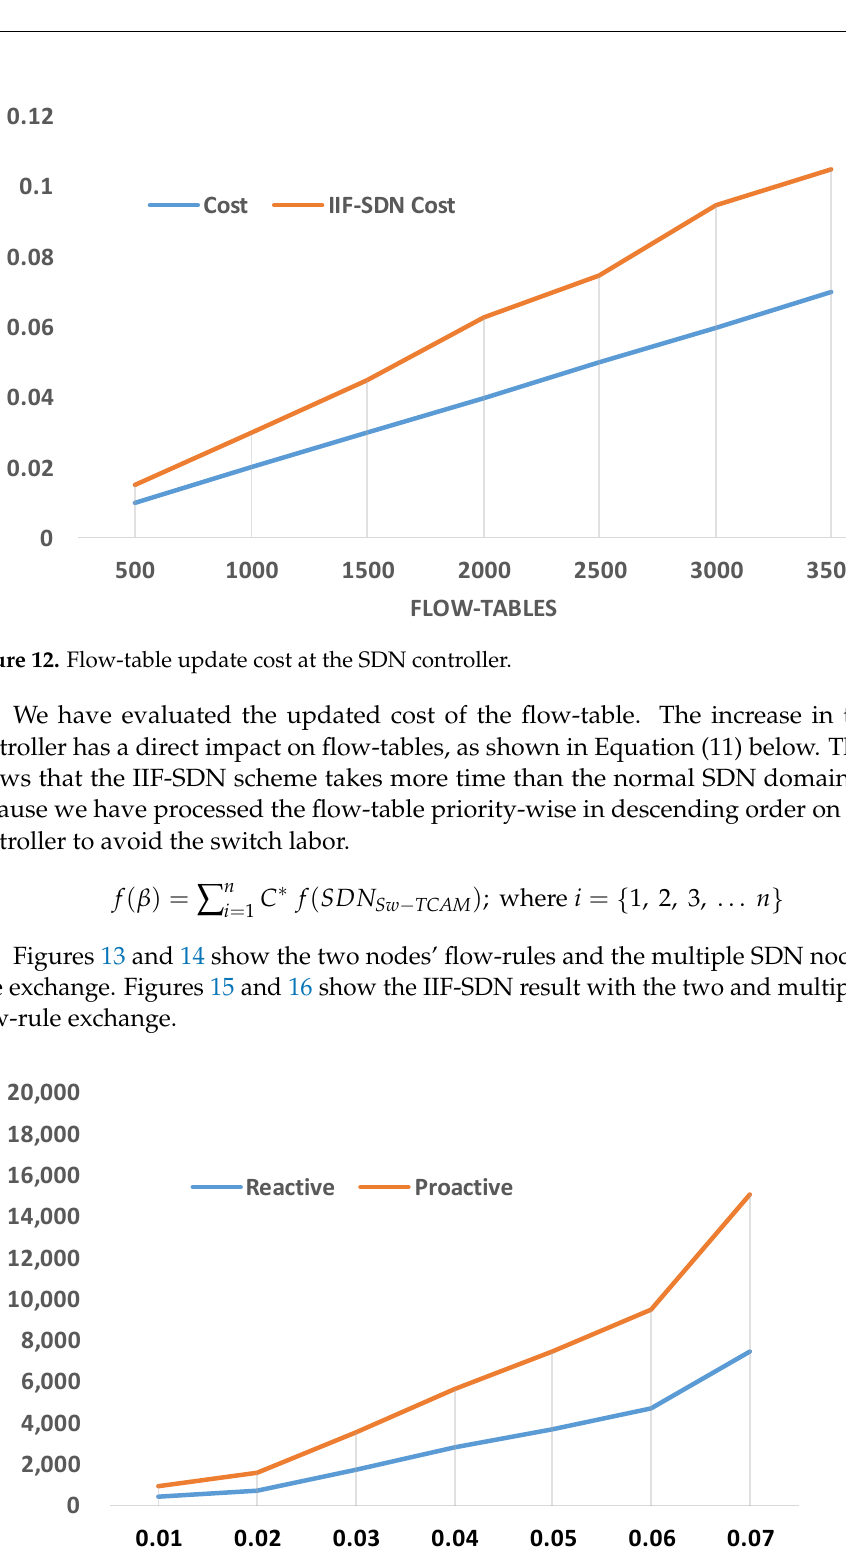
Figure 11. SDN domains and flow-tables.